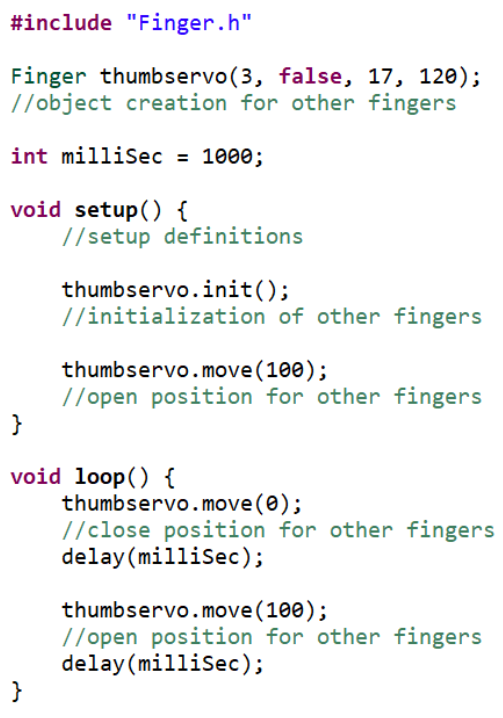
Figure 8. Generated code for Arduino